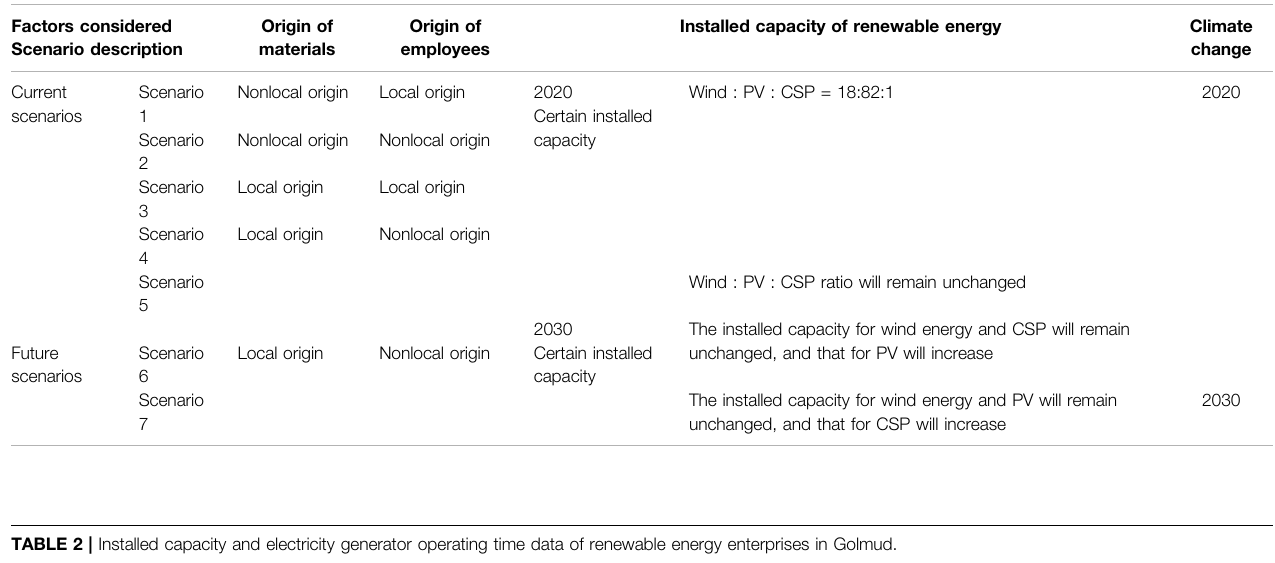
TABLE 1 | De fi nition of scenarios.